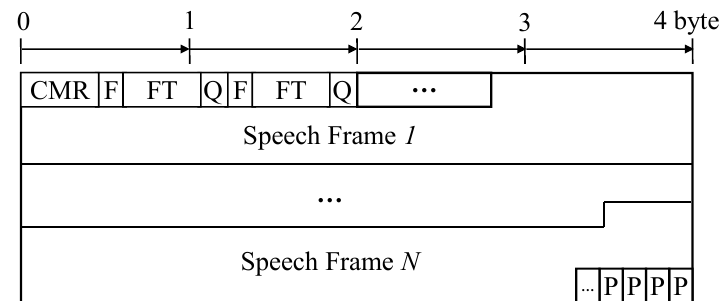
Figure 4. The RTP payload format for AMR-NB speech codec defined in RFC